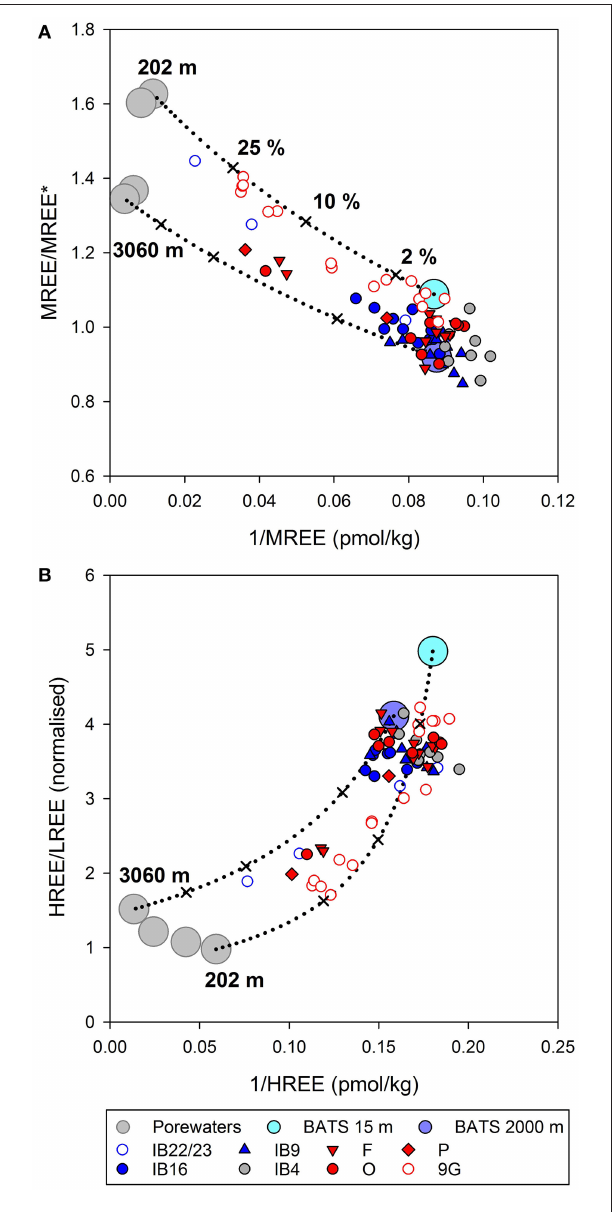
FIGURE 10 | Mixing plots of (A) MREE/MREE* vs. 1/MREE, and (B) HREE/LREE vs. 1/HREE, to highlight the combined effects of REE composition and concentration. The MREE/MREE* and HREE/LREE are calculated using PAAS normalised data, and the non-normalised concentrations are used for 1/MREE and 1/HREE (pmol/kg). Data for BATS seawater (15 and 2,000m) are from van de Flierdt et al. (2012). The pore water data are from Abbott et al. (2015b) and represent the average REE concentrations in pore waters of the top 5cm of sediment from cores HH200, HH500, HH1200, and HH3000, corresponding to water column depths of 202, 500, 1,216, and 3,060m respectively. The shallowest and deepest cores are labelled in the figures, with the intervening cores between these in depth order. Mixing lines are represented by dotted lines between BATS 15m and pore waters at 202m depth, and BATS 2000m and pore waters at 3,060m depth. The crosses on the mixing lines represent pore water REE contributions of 2, 10, and 25% to BATS 15m (HH200) and BATS 2000m (HH3000). The % contributions are labelled for mixing between BATS 15m and HH200 in the top panel only for clarity. To note, surface waters from O and all 9G samples were not